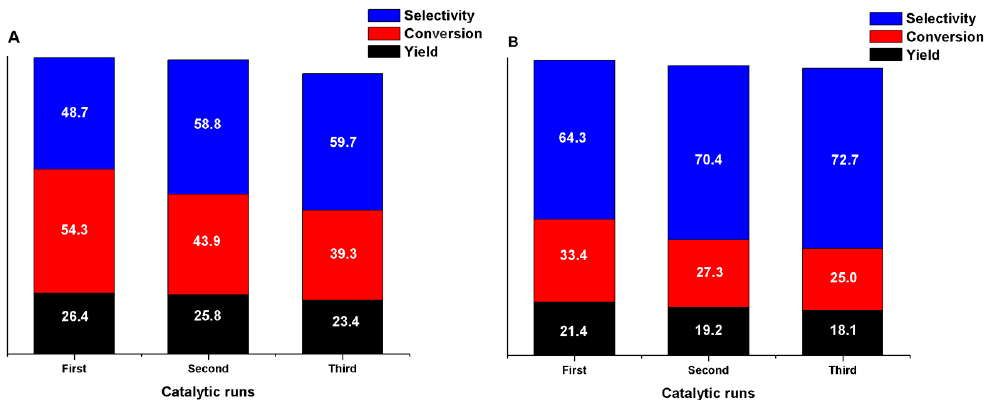
Figure 15. Performance of recovered solids after three catalytic cycles: Ce-MCM-Cl ( A ) and Ce-MCM-NO 3 ( B ).